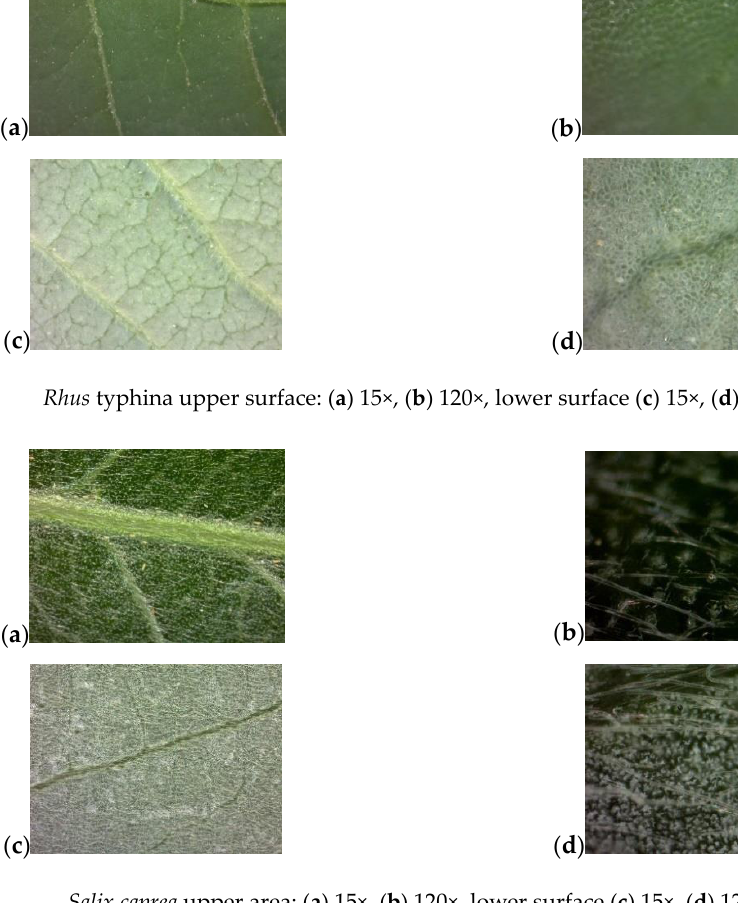
Figure A1. Photos of the top and bottom surfaces of the leaves. Figure A2. Photos of the top and bottom surfaces of the